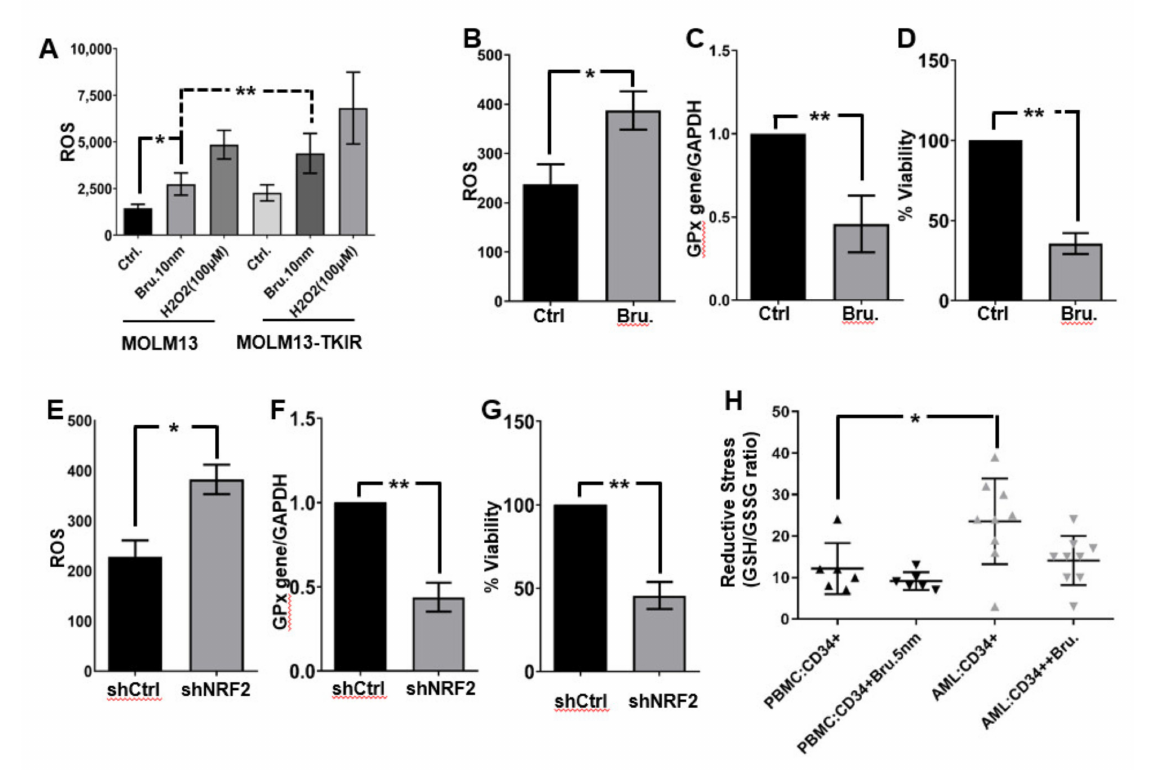
Figure 4. Targeted NRF2 inhibition promotes anti-leukemic effects in AML in vitro and ex vivo. ( A ). Flow cytometry detection of ROS in MOLM13 and MOLM-TKIR cells treated with brusatol and H 2 O 2 for 24 h using DCF. ( B ). ROS levels were measured after brusatol treatment at 10 nM in patients’ primary AML samples (after 24 h) using DCF. ( C ). qRT-PCR based GPx gene expression levels were detected in samples from panel B. ( D ). Cell viability measured after 36 h in brusatol cells from panel B. ( E – G ). Same parameters as in ( B – D ), respectively, after NRF2 knock-down cells. ( H ). Ex vivo analysis of CD34 + cells from normal PBMC and patients’ primary AML cells, treated with brusatol for 24 h, and reduced/oxidized glutathione was measured as an indicator of reductive stress in AML. Biologically independent samples were plated in triplicates (as technical replicates), but statistics were performed only on biologically independent samples ( n = 5), except for panel A and B. All experiments were repeated three times. Statistical significance is shown by p -values less than